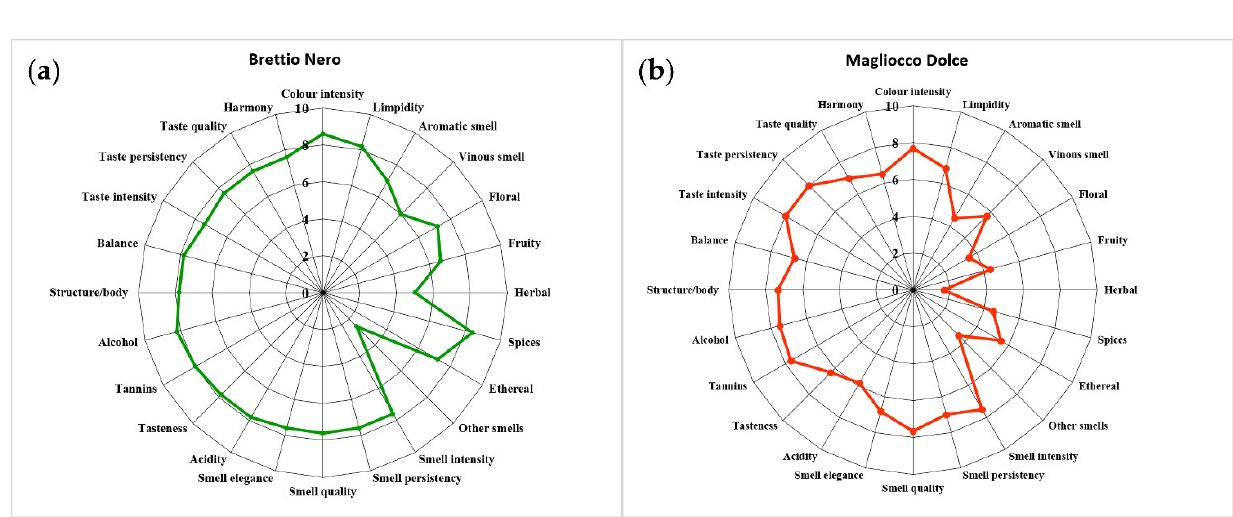
Figure 4. Brettio Nero ( a ) and Magliocco Dolce ( b ) monovarietal wine sensorial profiles based on 24 parameters evaluated by consumer volunteers.